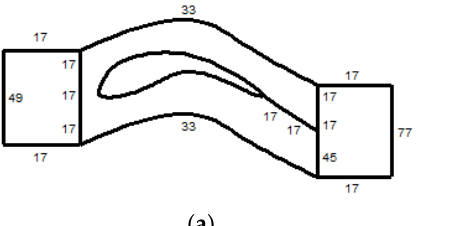
Figure 2. Schematic diagram of model mesh: ( a ) H-O-H topology; ( b ) computational grid.